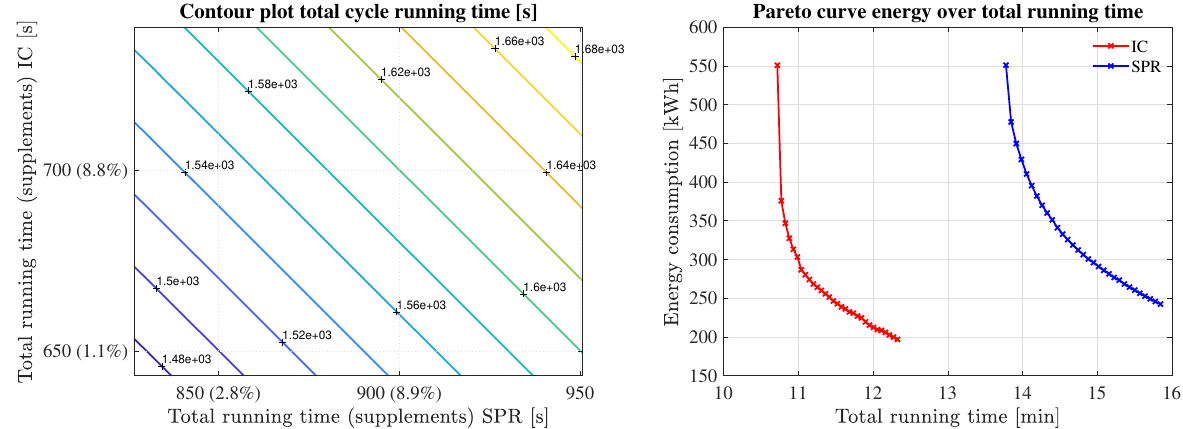
Figure 6: The left plot shows the contour plot for the case Ah-Nm for the total cycle running time over the total running time (supplements) for the SPR and IC. The right plot indicates the Pareto frontier curve of the energy consumption over the total running time for the IC and SPR for the case Ah-Nm.